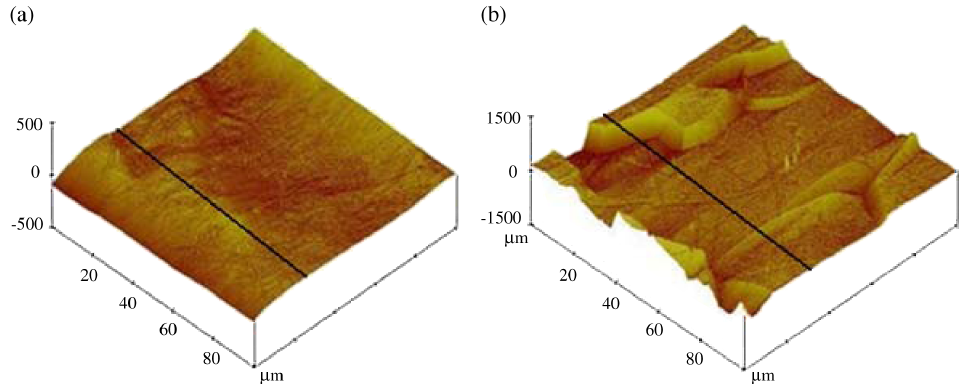
FIG. 12. AFM images of (a) nanopolished fine-grained sample as received and (b) after BCP with 6 (cid:1) m removal. The horizontal scale is 100 (cid:1) m by 100 (cid:1) m ; vertical scales are 500 and 1500 nm for (a) and (b), respectively.